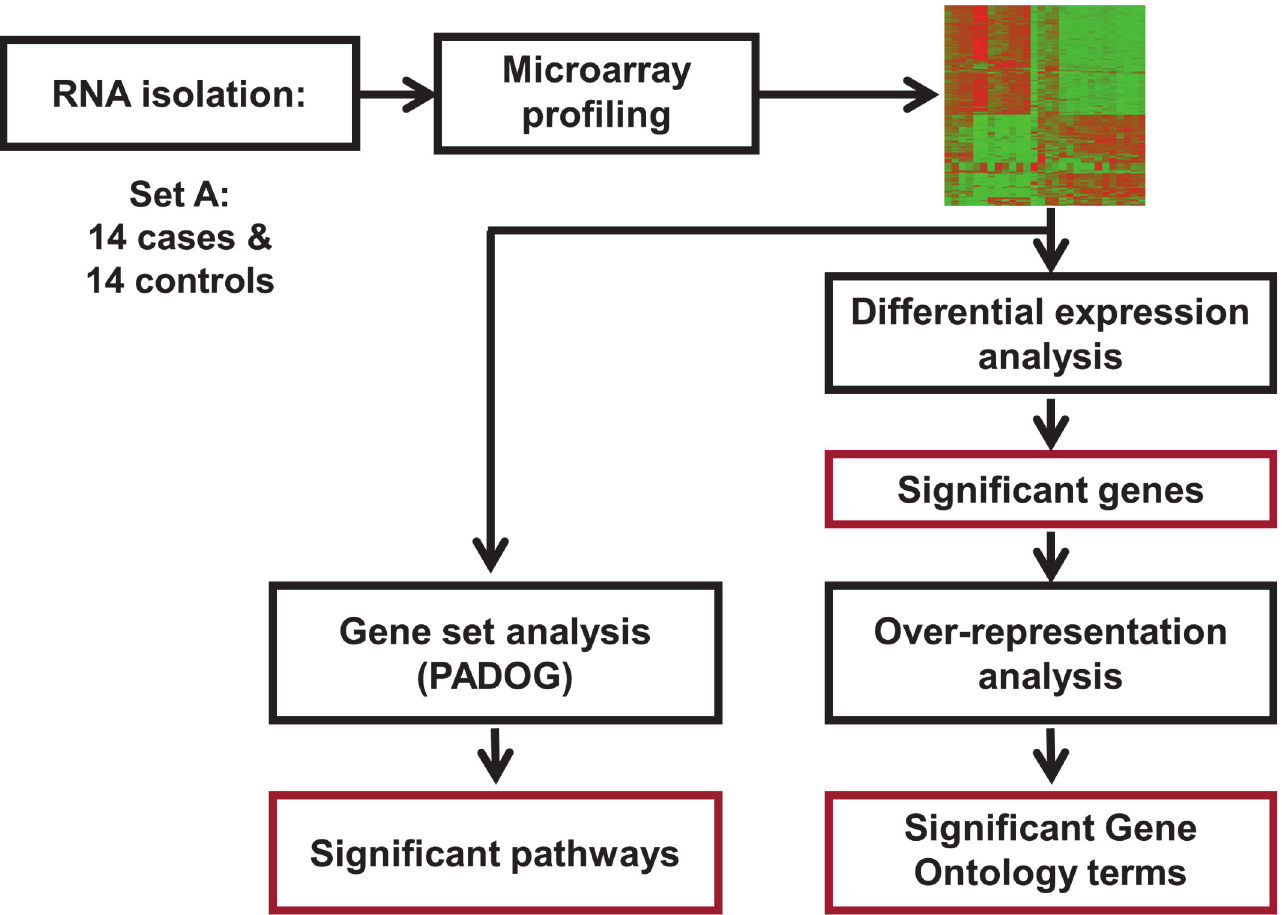
Fig 1. Microarray study flow diagram. The microarray analysis was performed on 14 cases and 14 controls (Set A) to identify significant genes, KEGG pathways and Gene Ontology